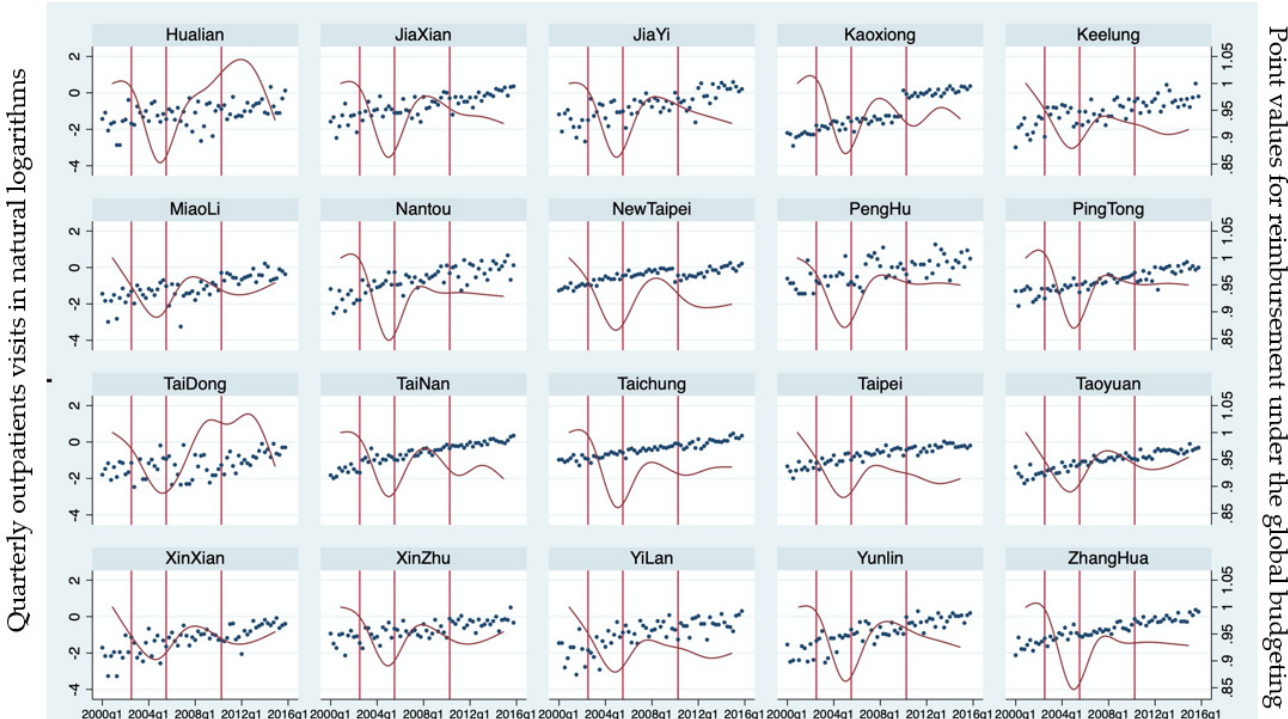
Figure 1. Total Outpatient Visits of Children with Refractive Errors by Patient Residential District. Note: Dots represent the quarterly volume of total outpatient visits per thousand children with refractive errors in each district in natural logarithms (the scale on the left-side vertical axis), and red lines denote the point values for reimbursement under the global budgeting system with the scale on the right-side vertical axis. The vertical lines represent insurance fee